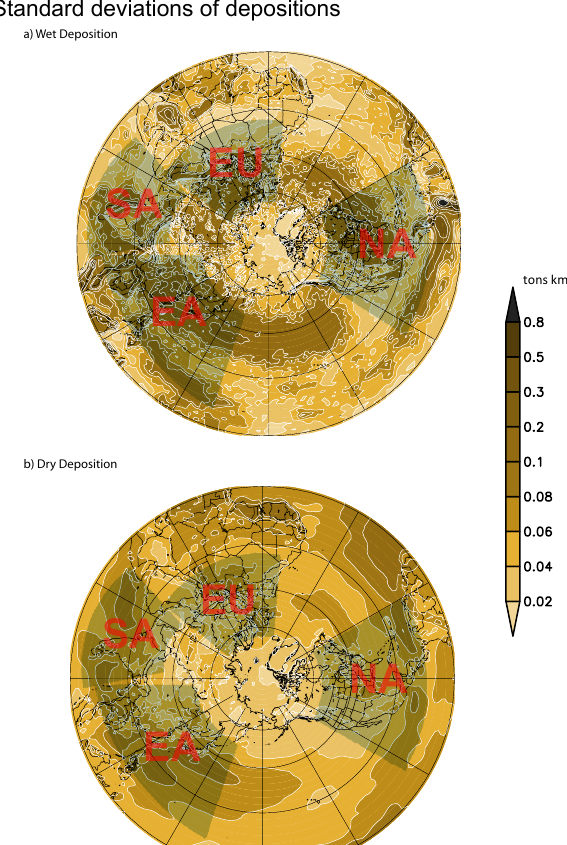
Fig. 9. Interannual variability of anthropogenic aerosol transport fluxes in the standard deviations (µgm − 2 s − 1 ) over 1995–2004 (a) in free troposphere of 3–10km and (b) in boundary layer below 3km. Fig. 10. Interannual variability of (a) wet and (b) dry anthropogenic